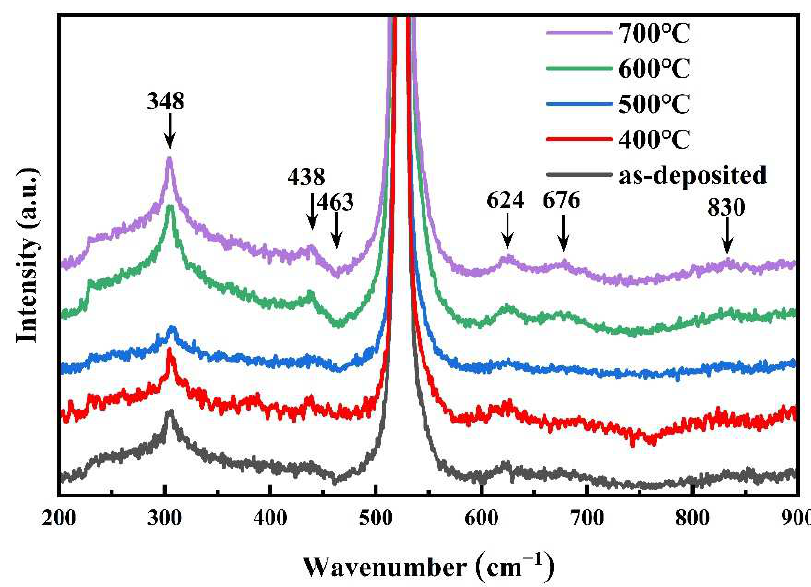
Figure 3. Raman spectra of lanthanum-doped HfO 2 films at different temperatures.